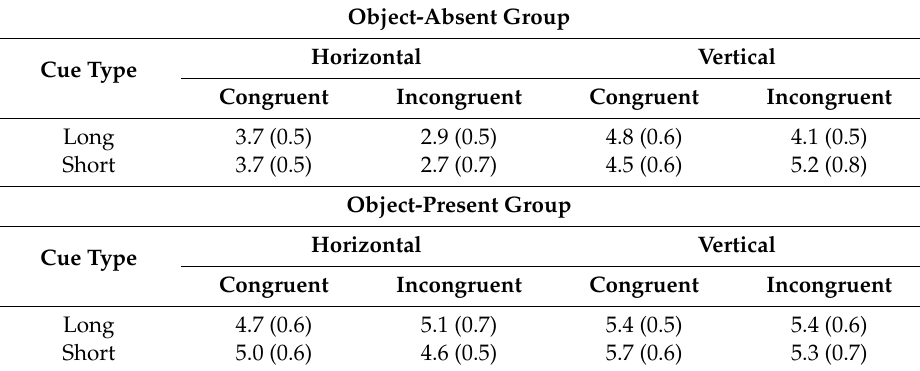
Table 1. Mean error rates (percent incorrect) as a function of object, cue type, target configuration orientation, and cue-target congruency in Experiment 1. Within-subject standard errors are in the